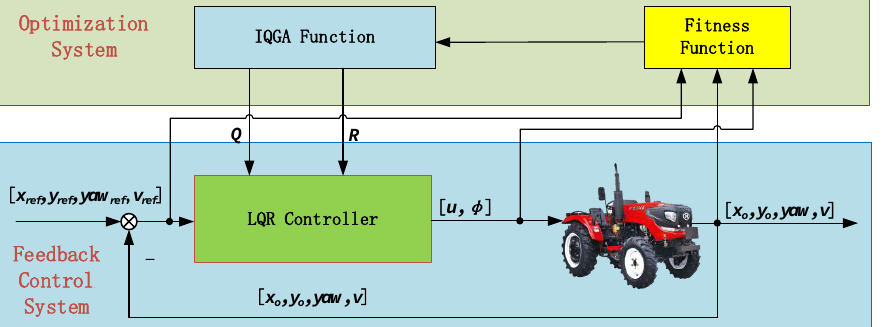
Figure 2. Schematic diagram of control parameter optimization based on IQGA.